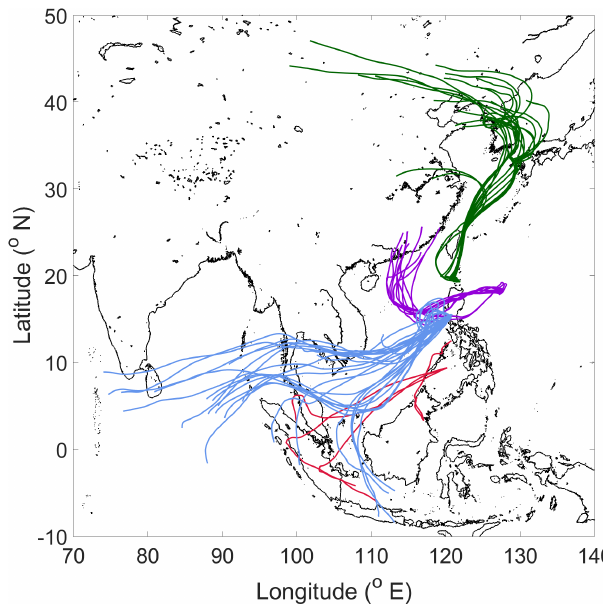
Figure 5. Spatial summary of 120h back trajectories for each sam- ple included in respective case study sample sets: North (green; n = 20), East (purple; n = 11), Biomass Burning (red; n = 4), and Clark (blue; n =